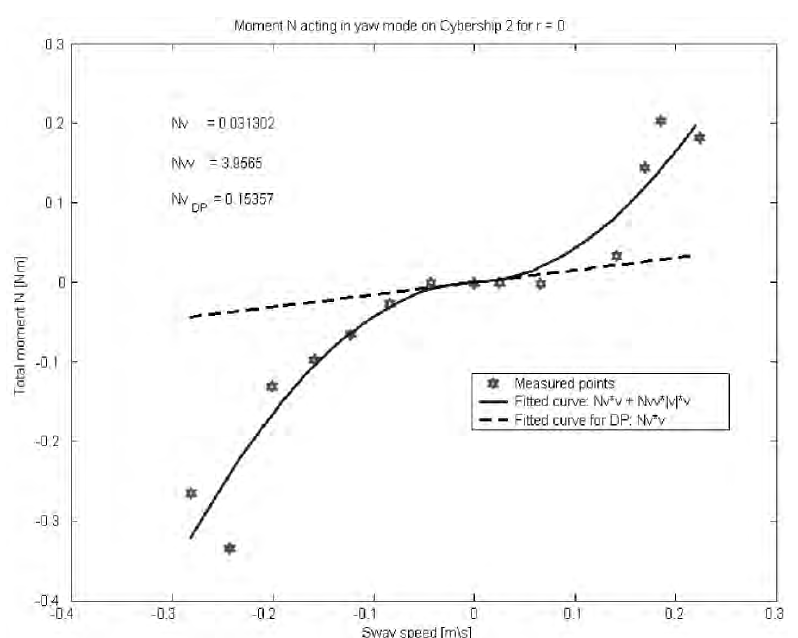
Figure 9. Measured drag moments in sway motion and the corresponding fitted nonlinear curve as well as a linear curve for DP for CyberShip II.